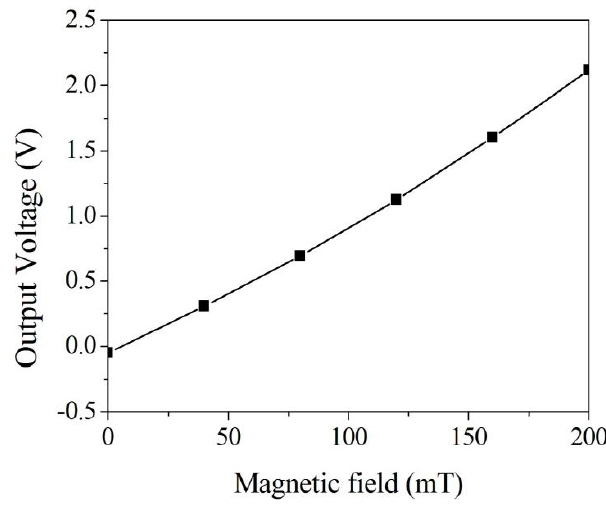
Figure 7. Simulation of output voltage for the sensing